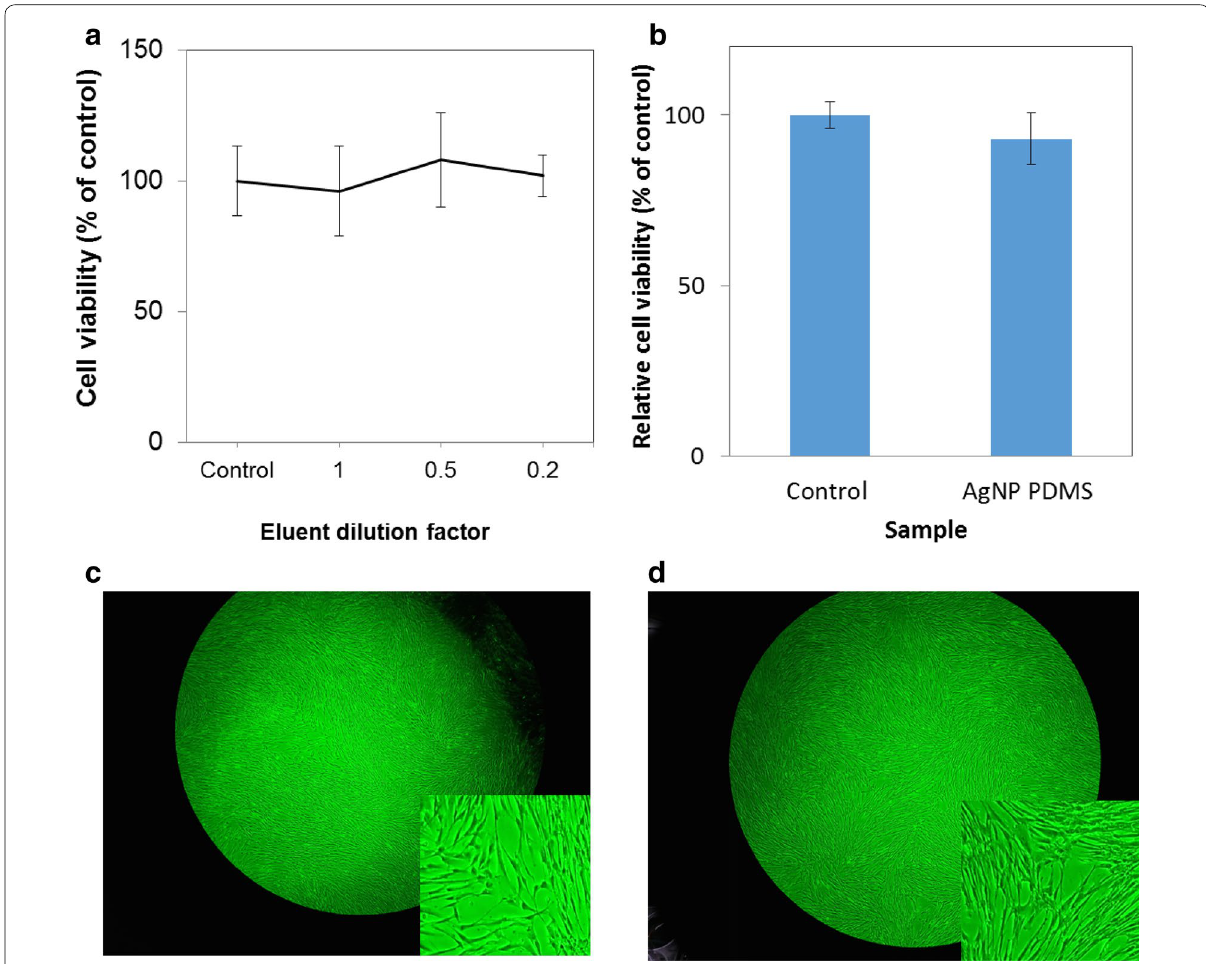
Fig. 9 Cytotoxicity tested with a eluent and b direct contact of the AgNP-grown PDMS film. Microscopic images of the tested cells grown in direct contact with c control PDMS film and d AgNP-grown PDMS films. Inset of c and d is enlarged image of each figure